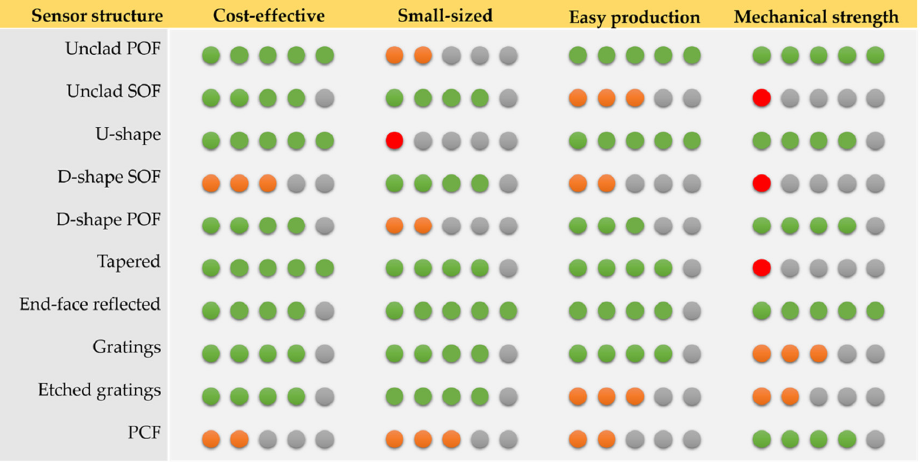
Figure 5. Infographic of the main characteristics of several optical fiber structures (green: great–good; orange: medium–fair; red: poor).